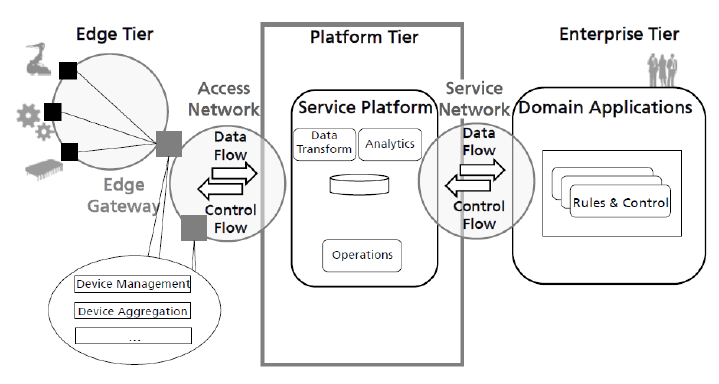
Fig. 2 Three-tier business model of electric power communication